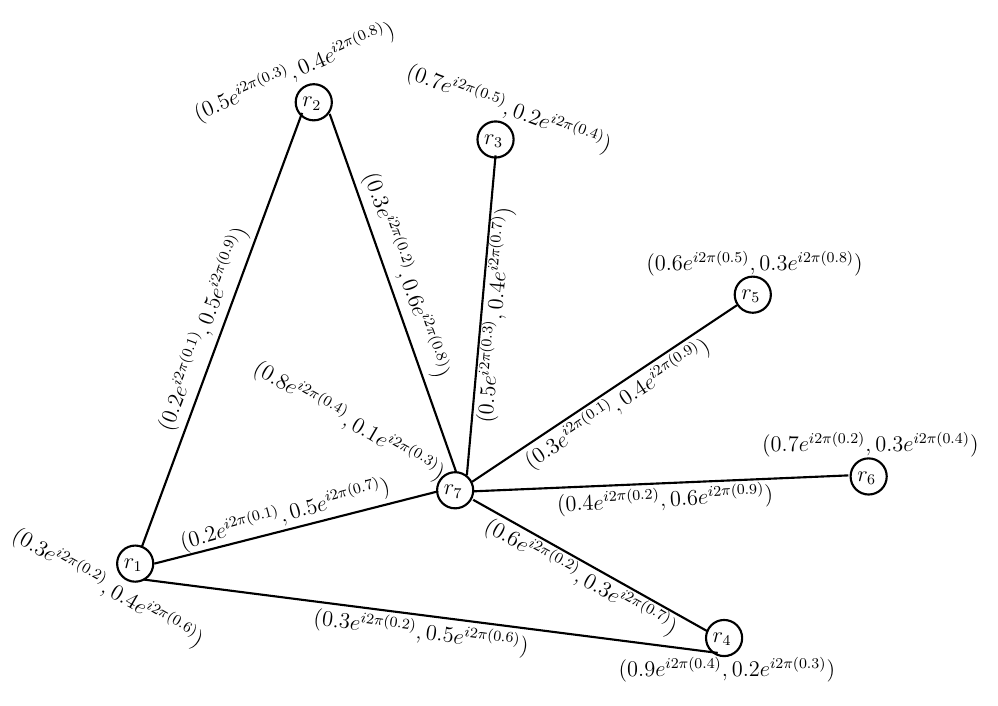
Figure 13. The relationships among the factors r i ( i = 1,2, . . . ,7 )